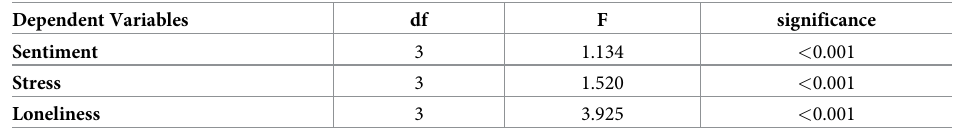
Table 2. Univariate ANOVA